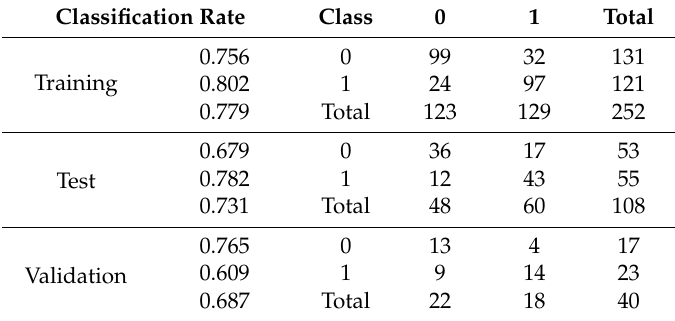
Table 3. Classification table with the results for the best occurrence model. The model was generated with Neural Works Predict ® v.3.30 software. This occurrence model was used to generate a 20-m resolution ignition probability grid (Figure 4). Geospatial variables associated with the historical fire ignitions (200 fire ignitions, 1985 to 2013 fire records; mapama.gob.es) (1) and a random sample with the same number of no-fire observations (0) were included within the fire modeling domain. A set of 40 cases (10%) was used for the validation of the